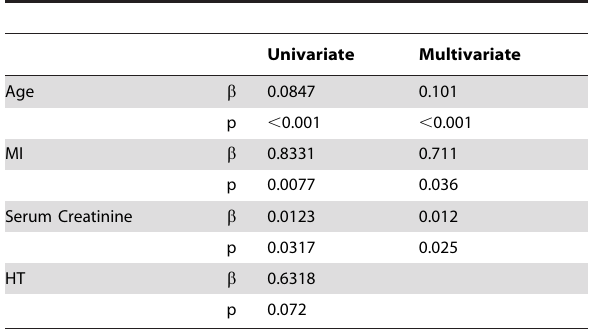
Table 2. Beta values and significance of the variables in the logistic regression univariate and multivariate